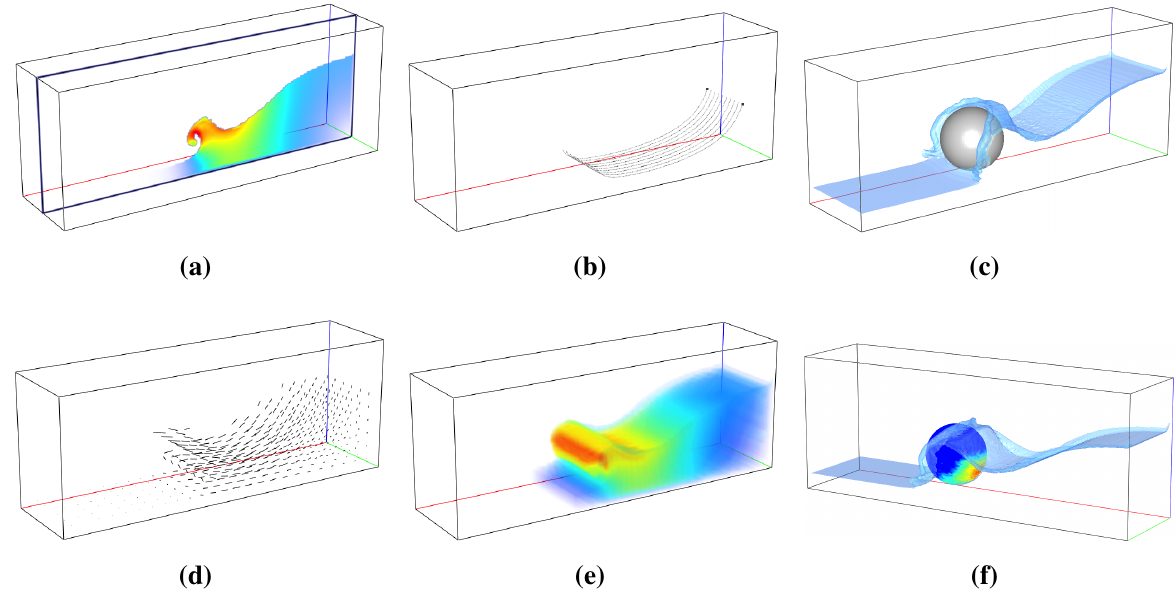
Figure 3. Six different visualizer features of ELBE vis : ( a ) colored slice, ( b ) streamlines, ( c ) geometry rendering, ( d ) velocity vectors, ( e ) volume rendering, ( f ) surface mapping.